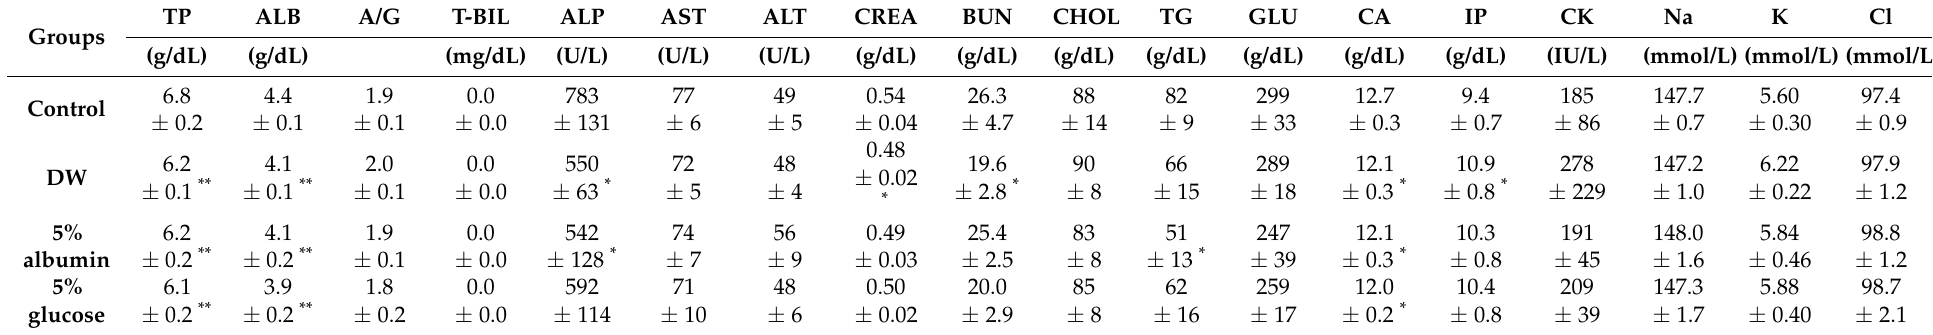
Table 4. Serum biochemical values of rats after oral administration of ZnO NPs (100 mg/kg) interacted with DW, albumin, or glucose for 14 consecutive days.